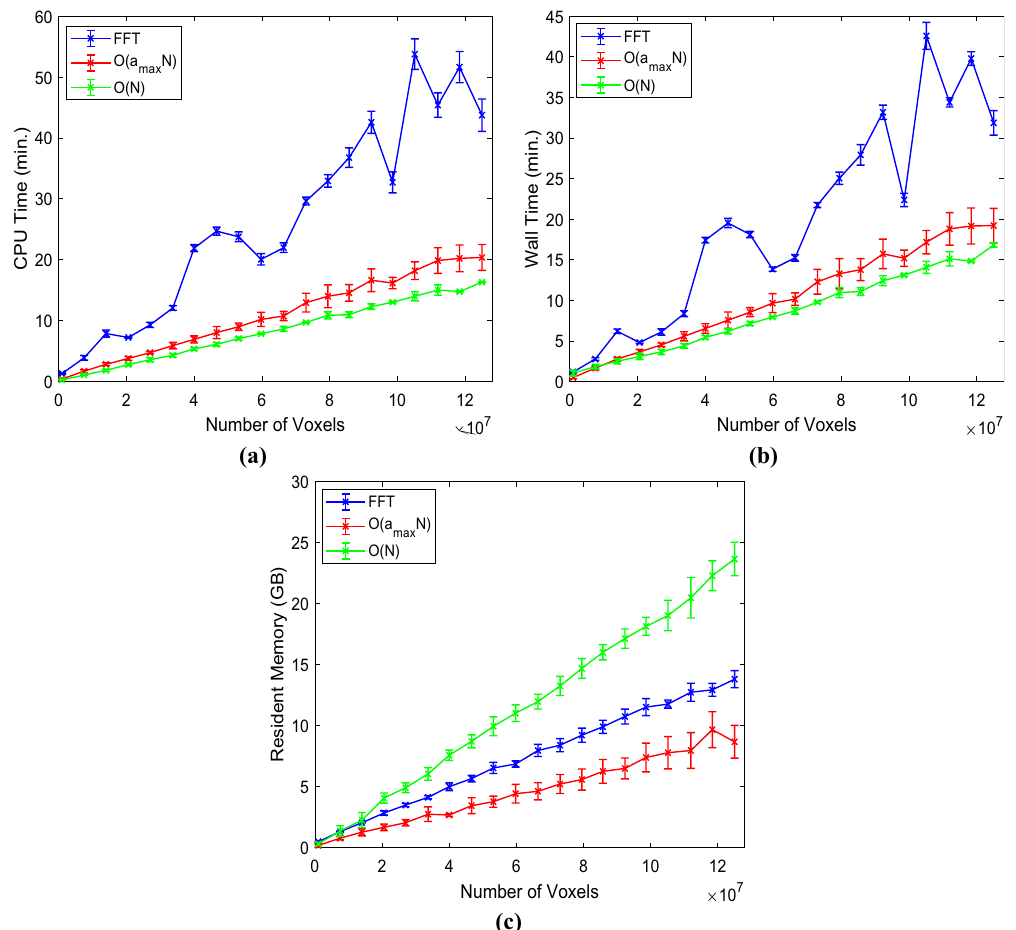
Figure 2. Analysis of runtime (CPU and wall time) and resident memory of O ( N ) (green), O ( a max N ) (red), and FFT-based (blue) approaches on synthetic data. As expected, the O ( N ) approach is the fastest of the three, with a linear trend with respect to the number of voxels. The runtime of the FFT method fluctuates due to the necessary zero-padding to the nearest power of